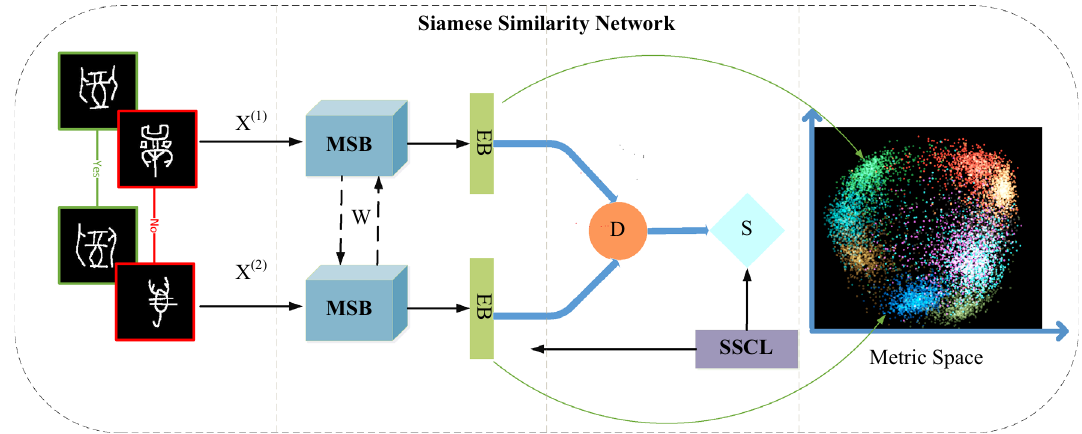
Figure 2. The structure of proposed SSN. It mainly includes multi-scale fusion backbone structure (MSB), embedding structure (EB), fusion distance layer (D), similarity layer (S) and soft similarity contrast loss (SSCL).